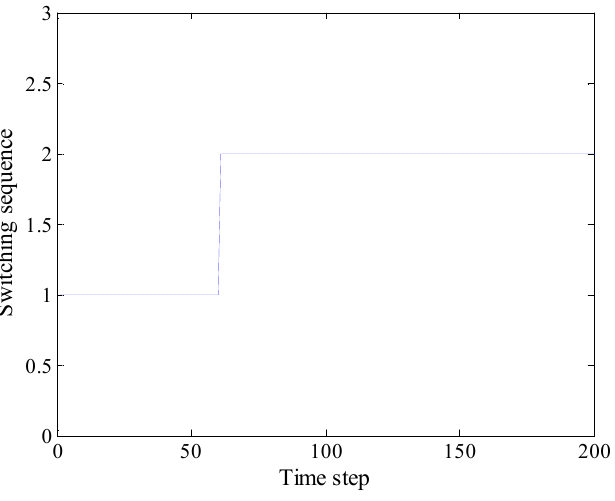
Figure 1. Switching rule. Figure 2 manifests the convergences of learning identification algorithm (44) with the different parameters selected as η 1 = η 2 = 0.01 and η 1 = η 2 = 0.5 under the given parameters ω 1 = ω 2 = 0.01 of DDOILC (45), respectively. It is shown that the estimation error of the Markov vector g = [ g 1 , g 2 ] decreases as the batch number increases, that is, that the rate of convergence of learning identification algorithm (44) accelerates as the parameters η 1 and η 2 decrease.